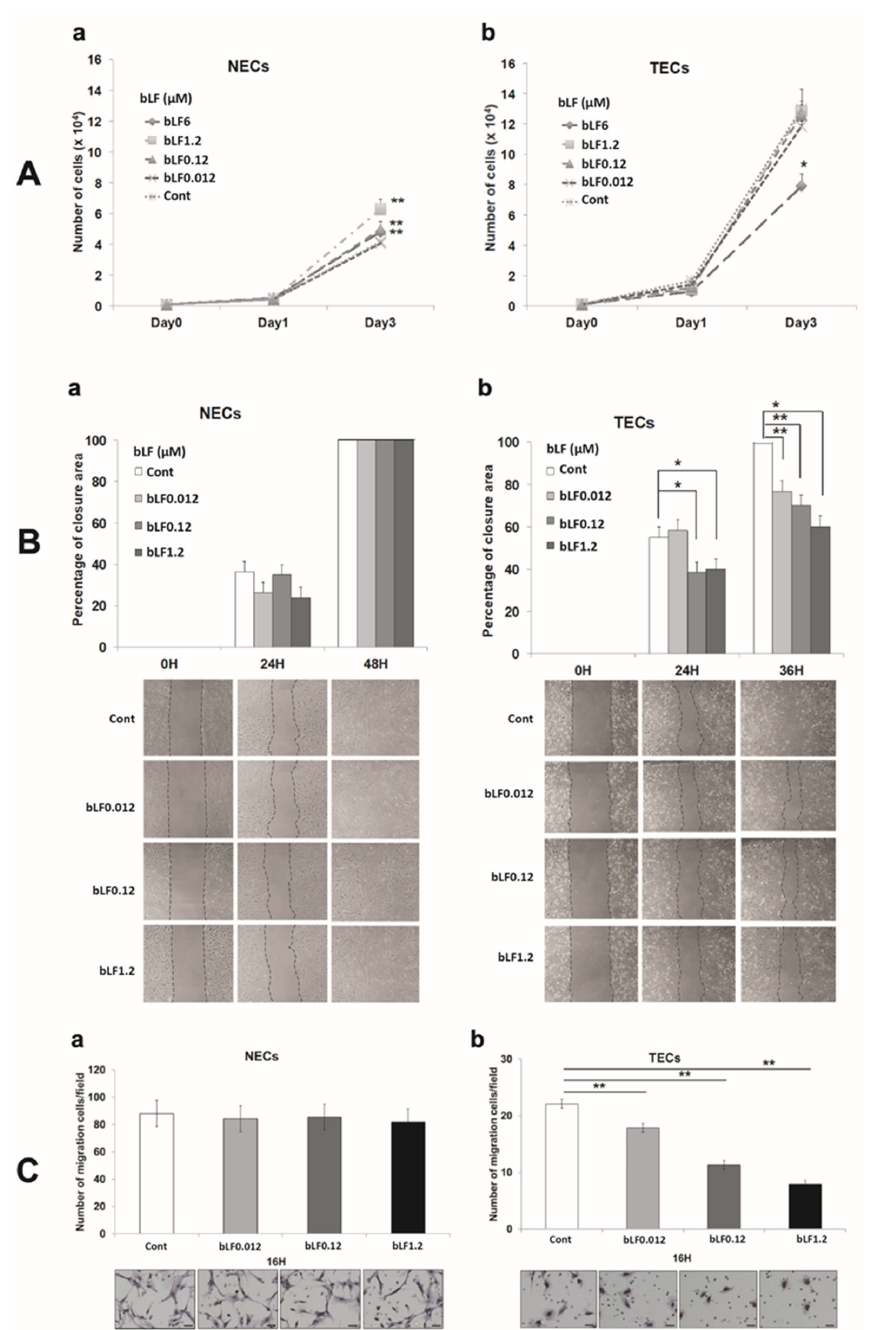
Figure 1. Effect of bovine lactoferrin (bLF) on proliferation and motility of normal endothelial cells (NECs) and tumor endothelial cells (TECs). ( A ) Number of cells treated with bLF (0.012, 0.12, 1.2 µM). ( a ) NECs and ( b ) TECs. ( B ) Data were analyzed by measuring the closure area and compared to the 0H control. Complete closure is represented by 100%. ( a ) NECs and ( b ) TECs. ( C ) Data analyzed by counting the number of cells migrated through membrane pores. ( a ) NECs and ( b ) TECs. Data represent the mean ± standard deviation (SD) of three independent experiments, each performed in triplicate. Statistical significances were determined by one-way analysis of variance (ANOVA). * p < 0.05, ** p <